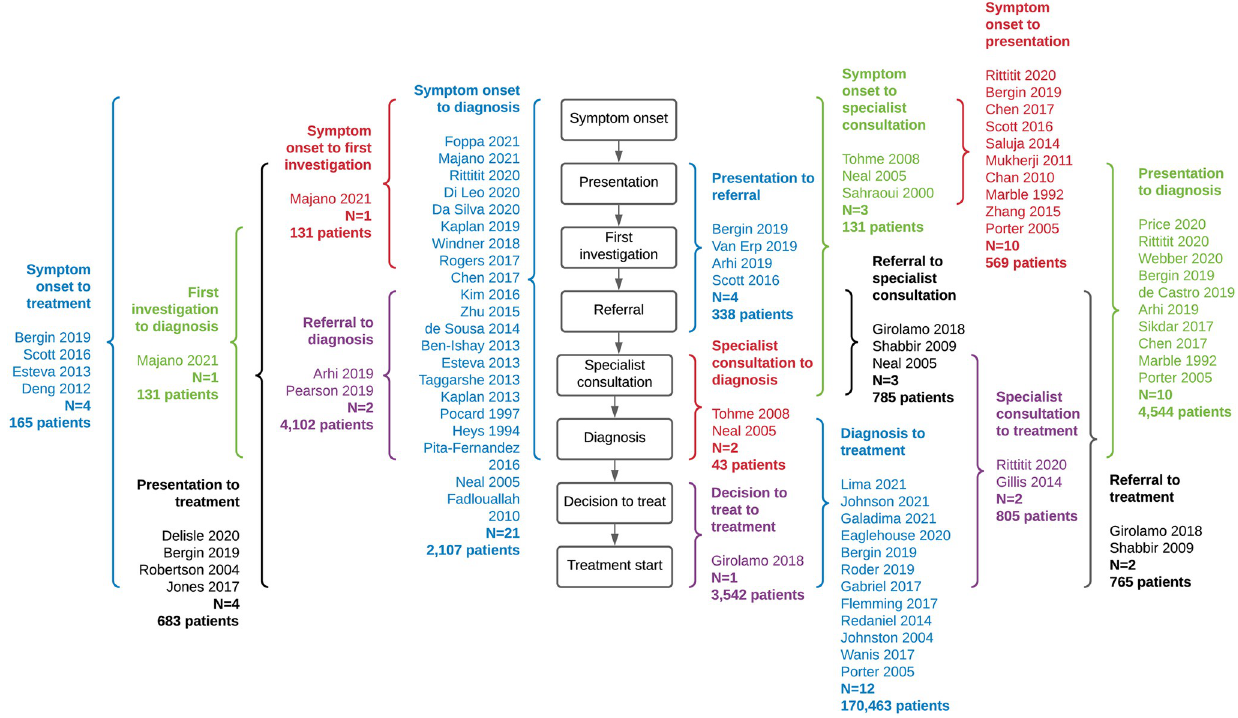
Fig 3. Summary of intervals and sample sizes across studies. Studies are grouped by interval reported, and the total sample size across all studies in each is presented.